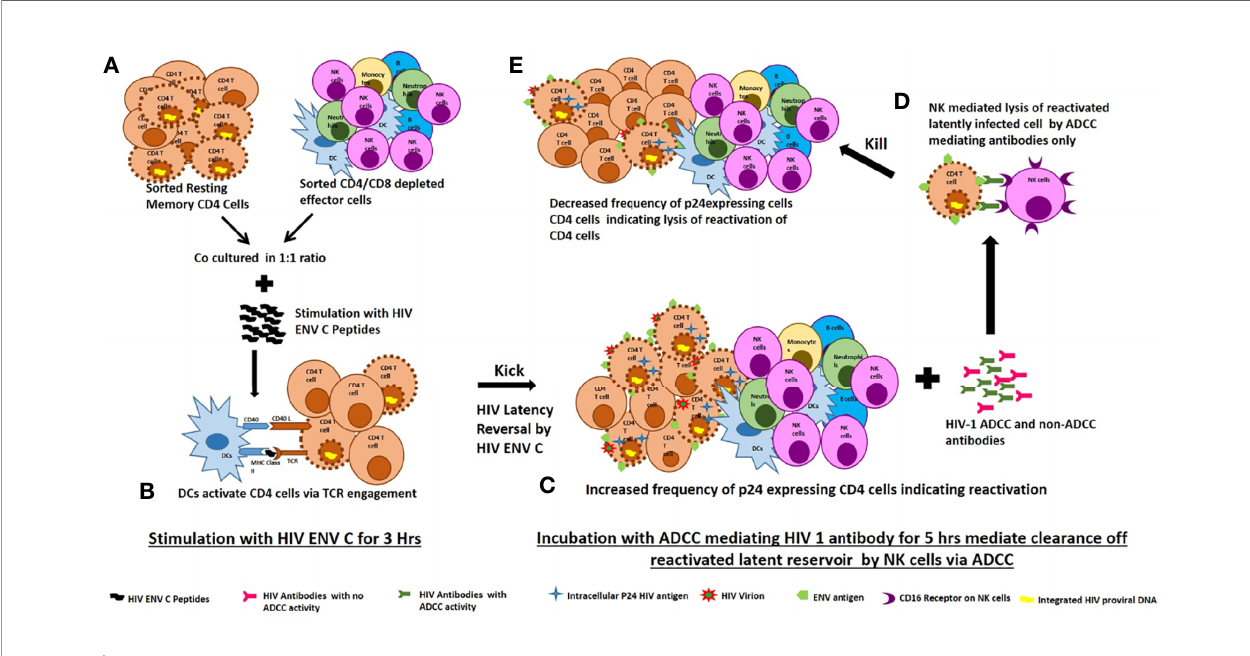
FIGURE 5 | Proposed mechanism of ENV-C reactivation of latent HIV reservoirs and their killing by ADCC mediating lysis by NK cells. (A) Sorted resting memory cells and sorted CD4/CD8 depleted effector cells were cultured at 1:1 ratio and stimulated with HIV ENV C peptides. (B) Dendritic cells speci fi cally present MHC II bound antigenic peptide to HIV speci fi c CD4 T cells via T cell receptor engagement. Activation of the T-cell receptor (TCR) induces multiple signal transduction pathways leading to the ordered nuclear migration of the HIV transcription initiation factors NF- k B and P-TEFb activate latent HIV proviruses through an ERK- dependent pathway. (C) HIV ENV C stimulation increased the frequency of p24 expressing CD4 cells indicating reversal of latency. (D) Addition of ADCC mediating antibodies mediate clearance reactivated latently infected cells by NK cells through ADCC. (E) The reduction in frequency of p24 expressing CD4 cells after addition of ADCC mediating antibodies indicates lysis of reactivated latently infected